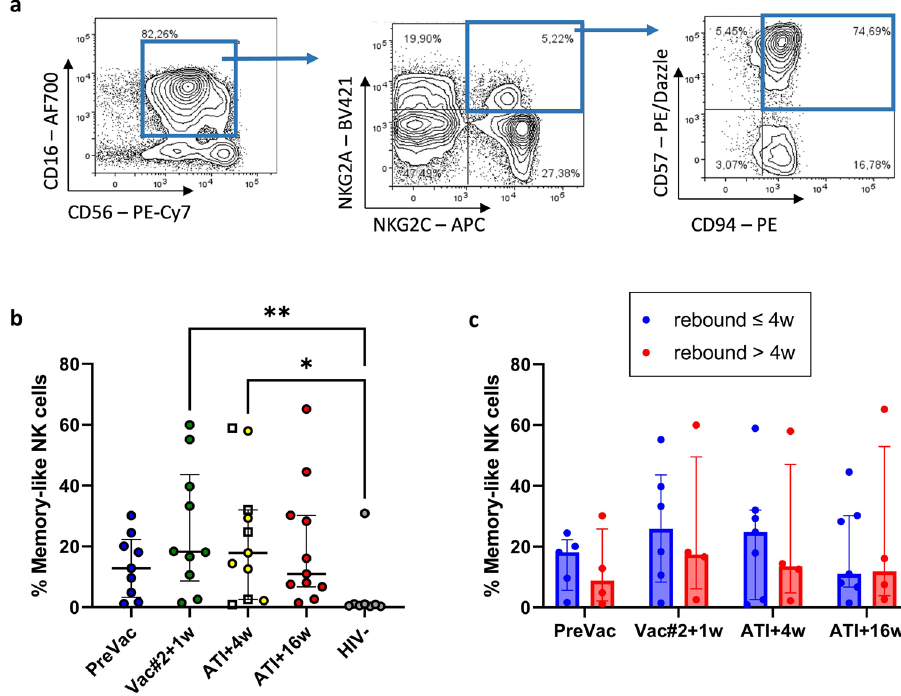
Fig. 5 Frequency of memory-like NK cells. a Gating strategy on a representative participant for determining memory-like NK cells. Gating was performed on viable CD56 dim CD16 + NK cells and subsequently on NKG2A − , NKG2C + , CD94 + and CD57 + NK cells. b Frequency of memory-like NK cells in blood of DC-TRN participants during the course of the trial compared to uninfected individuals (HIV-1 − ). Median ± IQR; Kruskal – Wallis test with Dunn ’ s multiple comparison test. Squares indicate participants who have rebounded at ATI + 4w. c Comparison in percentage of memory-like NK cells between participants who rebounded before or after 4 weeks of ATI. P -values <0.05 were considered statistically signi fi cant and graphically annotated as follows: * p < 0.05 and ** p <